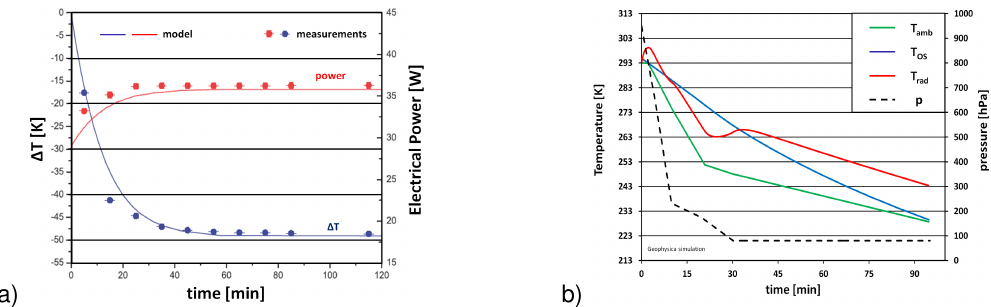
Fig. 8. Model simulation for the thermal behaviour during ascent: (a) the GBB prototype with a constant electrical current of 3A and (b) optimal cooling of GBB-C optical surface during a Geophysica ascent (calculated for I TEC =1.5A). Table 2. Physical properties of selected TECs at − 30 ◦ C.